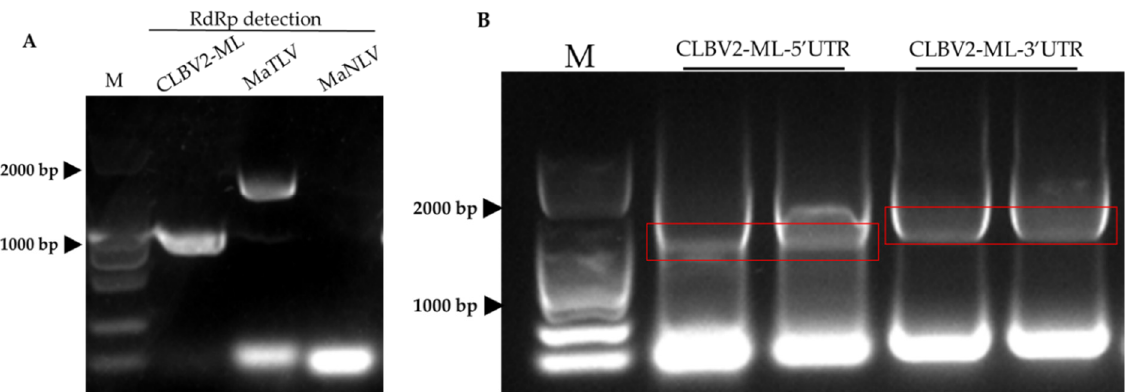
Figure 6. The detection of RdRp protein and UTR sequences. ( A ) The expression of RdRp proteins of CLBV-ML2, MaVLV, and MaNLV by RT-PCR. ( B ) RACE amplification of CLBV-ML2. M: Marker. Red boxes: 5’UTR and 3’UTR target strips.